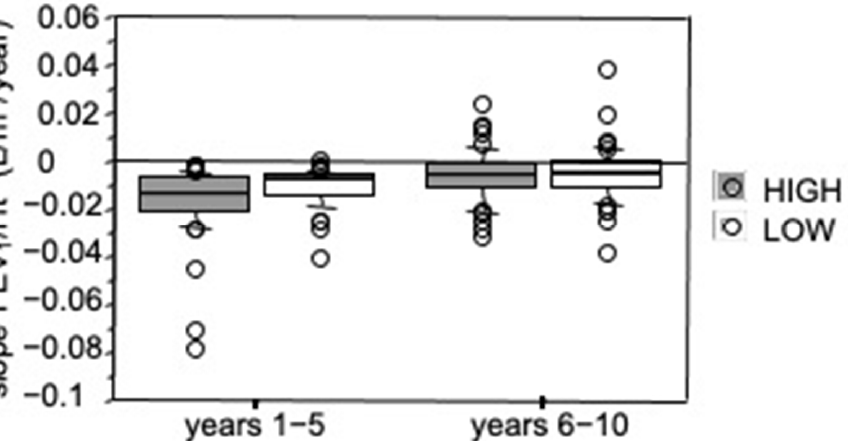
Figure 5. Slope values of relationships between height-adjusted FEV 1 and time (L/m 3 /year) during years 1–5 and years 6–10, separately for groups of FEV 1 variability at 1st year. Bars indicate (from the bottom to the top) 10th, 25th, 50th (median), 75th and 90th percentiles. Values below 10th and above 90th percentiles are plotted as circles. In years 1–5 subjects with FEV 1 variability at 1st year showed significantly lower slope values ( p < 0.04, Mann–Whitney U -test). No significant effect of variability was observed on FEV 1 slopes for years 6–10.